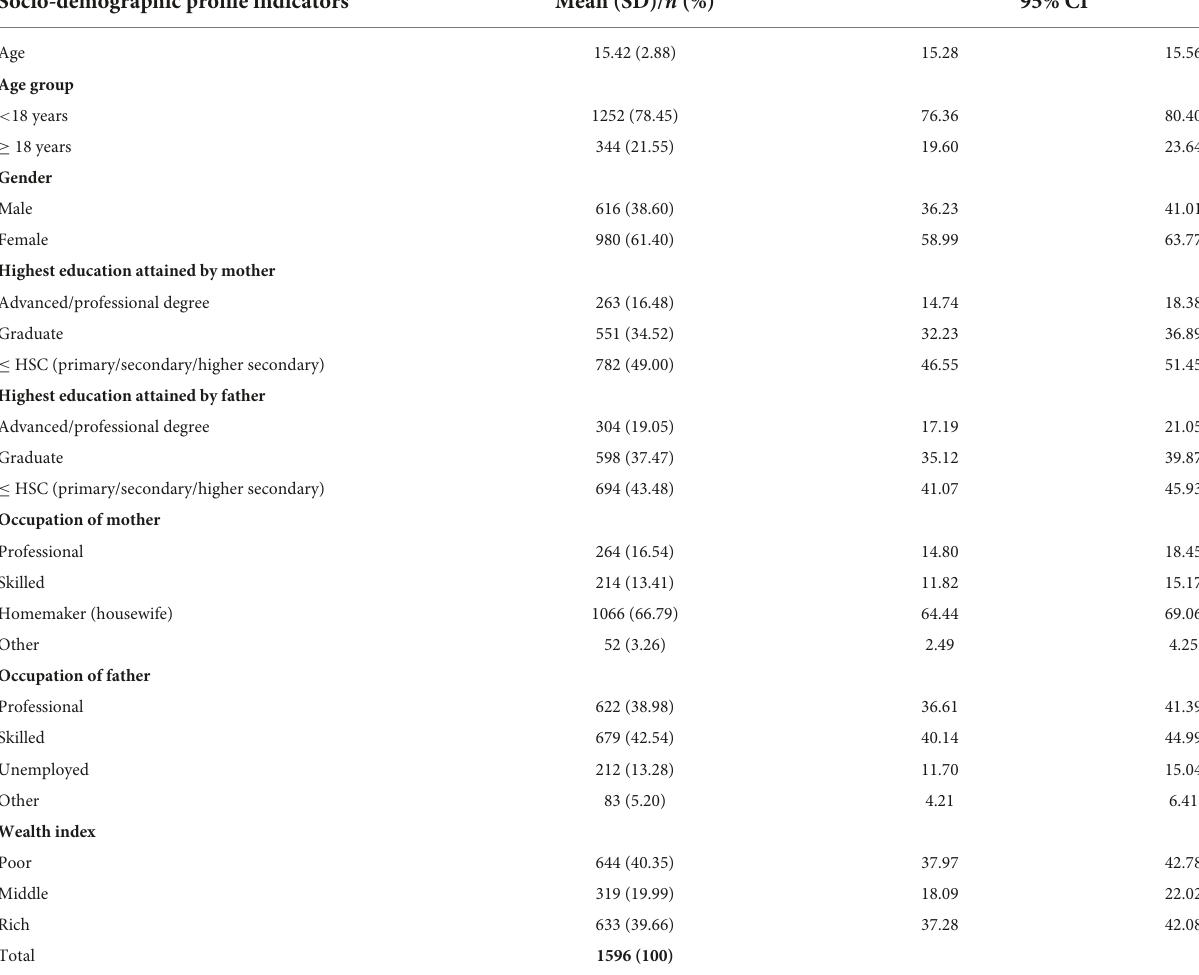
TABLE 1 Socio-demographic profile of the respondents ( n =